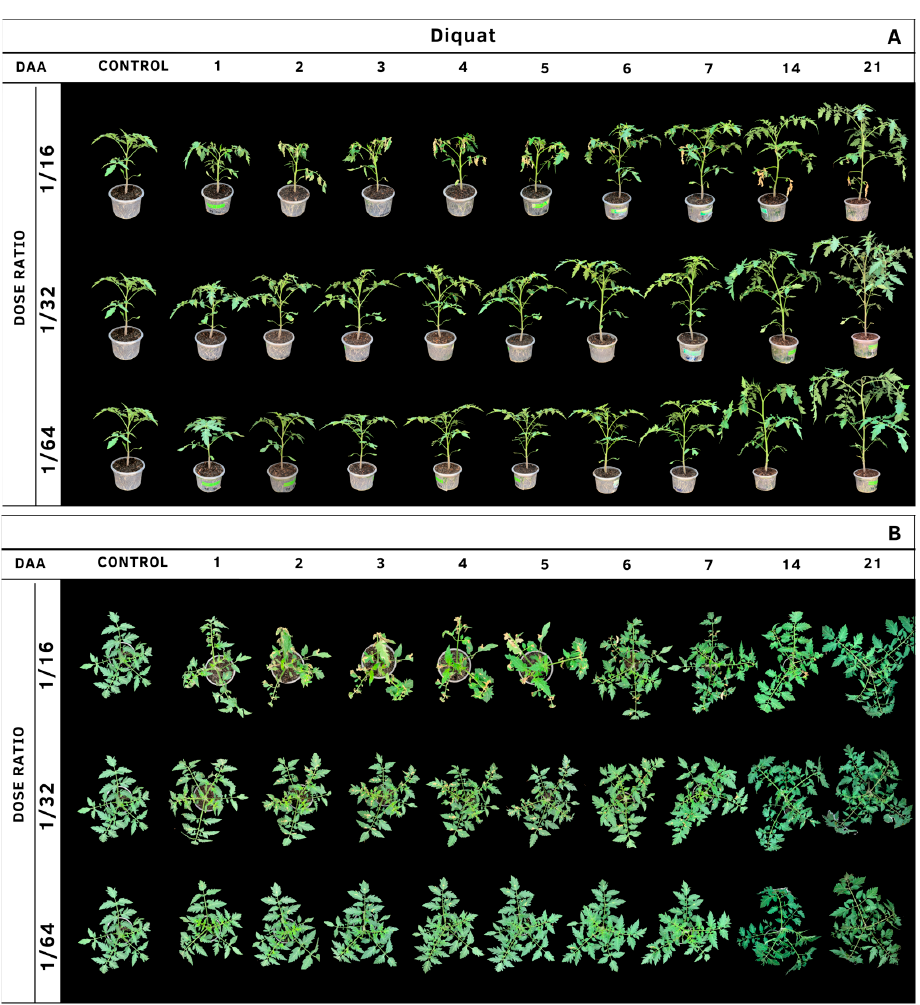
Figure 15. Symptoms evolution in tomato plants due to simulated diquat drift at dose ratios 1/16D, 1/32D, and 1/64D (43.75, 21.88, and 10.94 g a.i. ha − 1 , respectively) of the recommended dose (D). Evaluations were made from 1 to 7, 14, and 21 days after application (DAA). Front view ( A ) and top view ( B ) of tomato plants a ff ected by simulated drift.